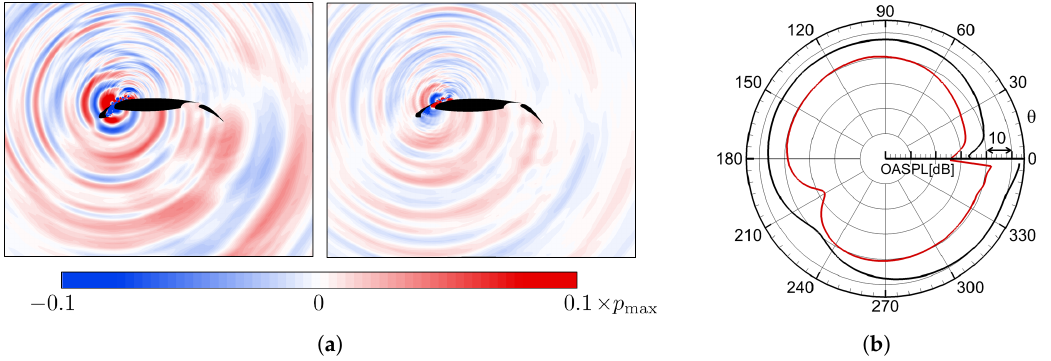
Figure 8. Noise reduction of VLCS at freestream flow speed U ∞ = 60 m/s. ( a ) Snapshot of fluctuating sound pressure field radiating from F16 reference airfoil (left) and VLCS (right), p max -maximum value of pressure fluctuation magnitude in field; ( b ) Directivity of overall sound pressure level for F16 (black) vs. VLCS (red).